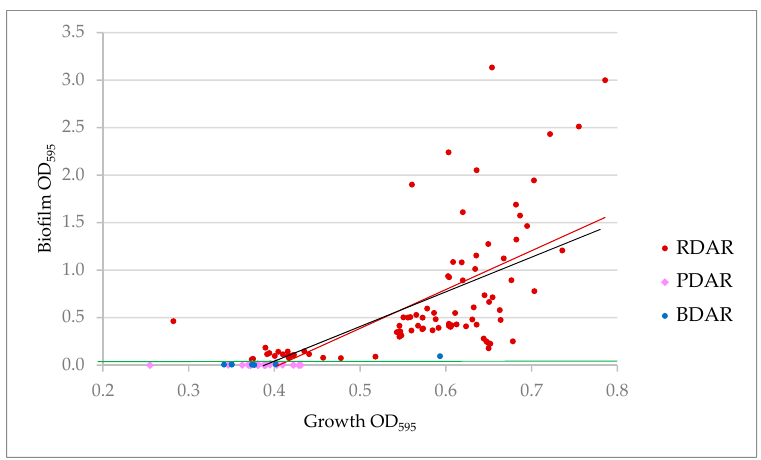
Figure 2. Correlation between OD 595 indicating growth and OD 595 indicating biofilm production in the crystal violet biofilm assay for all ESCR E. coli strains. Marker color codes show the morphotypes of the strains. Green line indicates cut-off value. The correlation trend line is black for all strains and red for the RDAR strains only. The equation indicates the strength and direction of the relationship and the R 2 value.